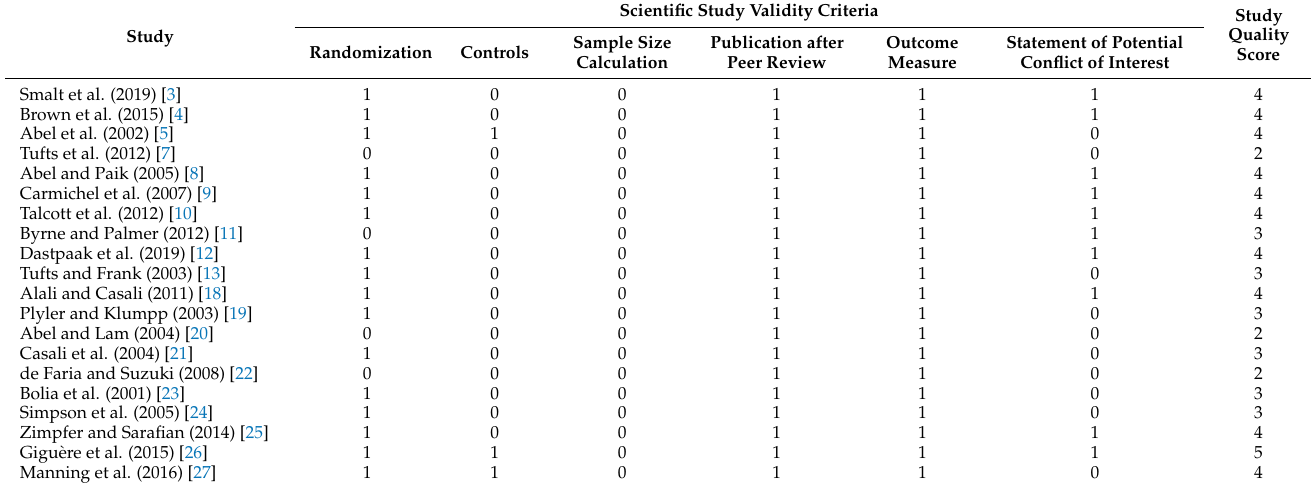
Table 2. Analysis of the scientific study validity criteria based on CAMARADES checklists [16].